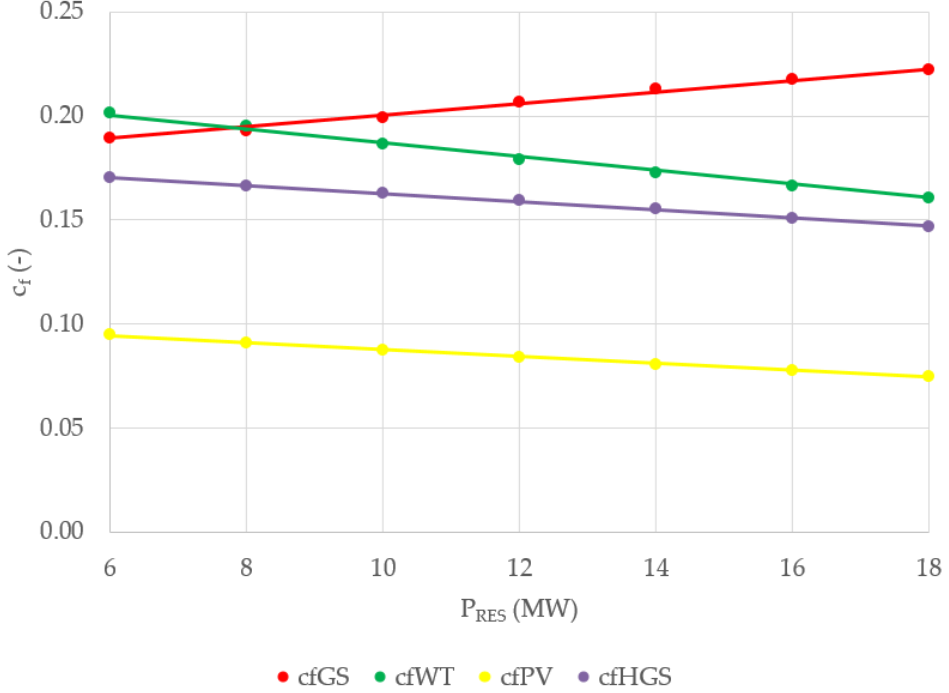
Figure 13. Capacity factor by source in the HGS.